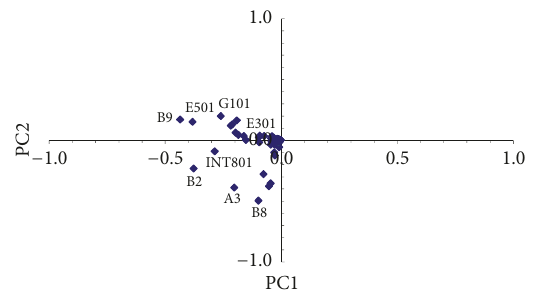
Figure 5: PCA of the total samples and possible point sources.